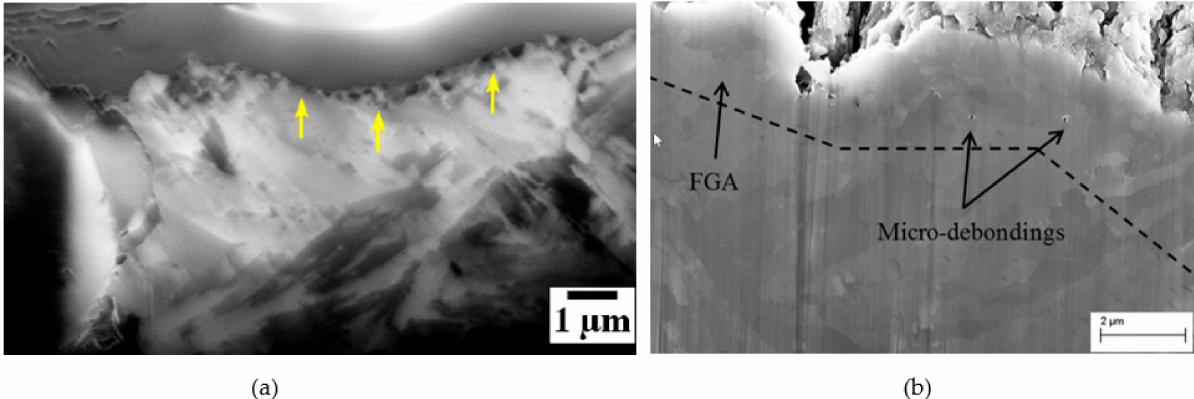
Figure 13. FIB sections through the internal crack initiation sites in ( a ) 50CrMo4—57HRC: nanograins within the FGA (yellow arrows) at an Al 2 O 3 -type inclusion (57HRC, σ a = 750MPa, N = 3.5 × 10 8 ), and ( b ) 16MnCrV7 7 lower bainite: an FGA without any non-metallic inclusion ( σ a = 400 MPa, N = 8.7 × 10 8